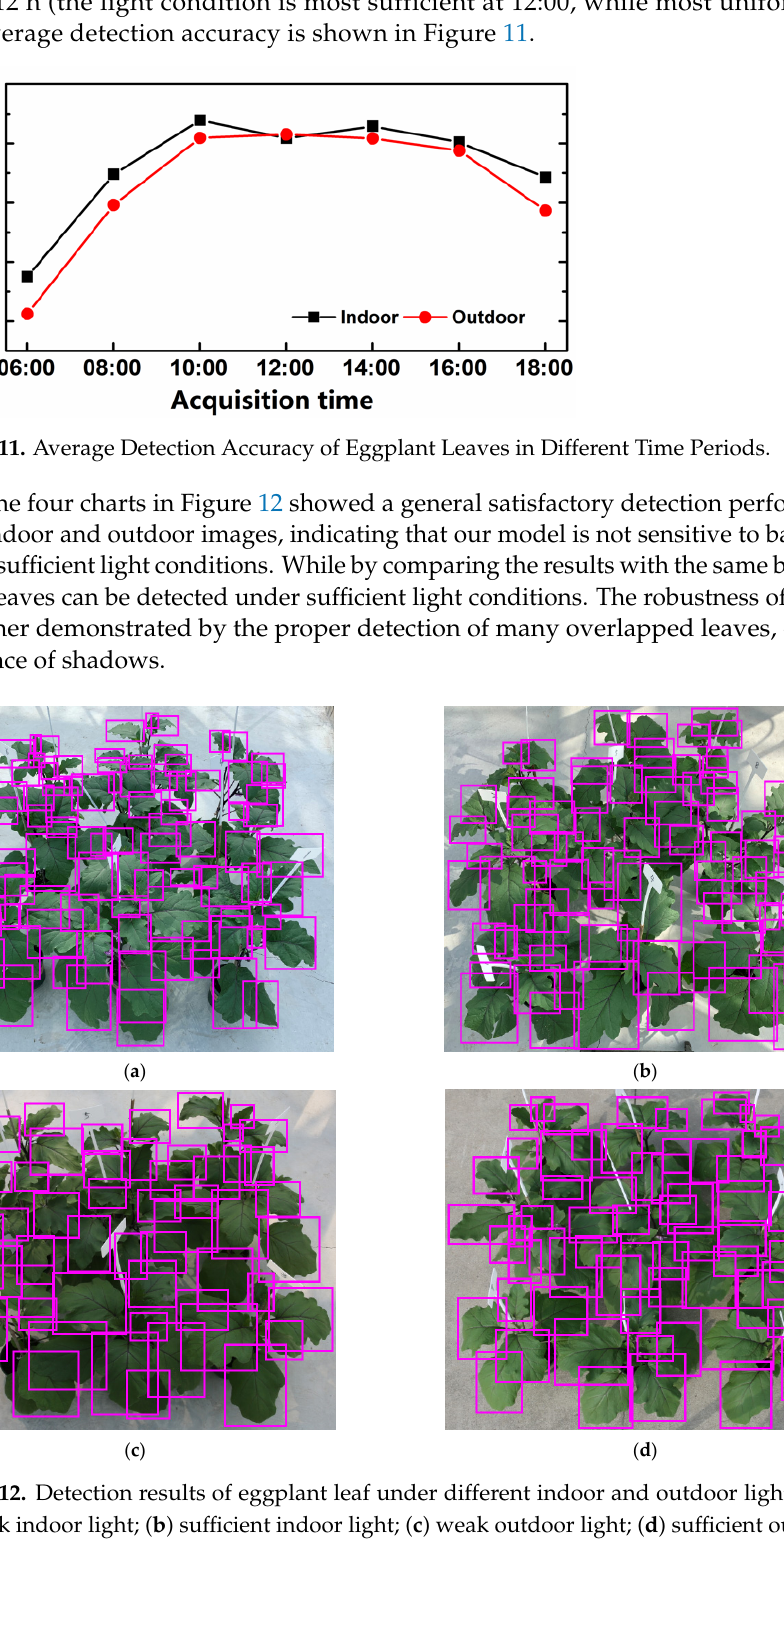
Figure 10. Visual detected results on different plants; ( a ) individual cucumber; ( b ) orchid grass; ( c ) pennywort; ( d ) egg- plants; ( e ) tomato; ( f ) group cucumber.